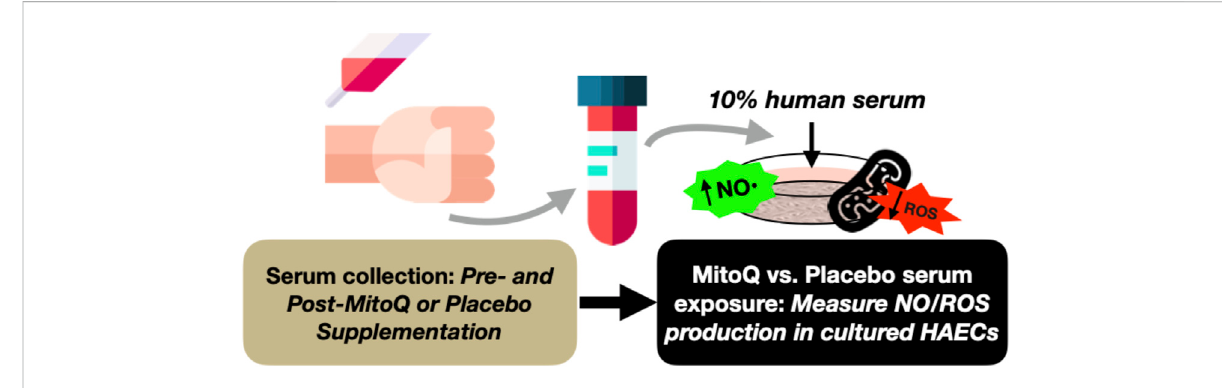
FIGURE 3 Experimental design to assess the in fl uence of changes in circulating factors on endothelial cell health before and after MitoQ or placebo supplementation. NO = nitric oxide; ROS = reactive oxygen species; HAECs = human aortic endothelial